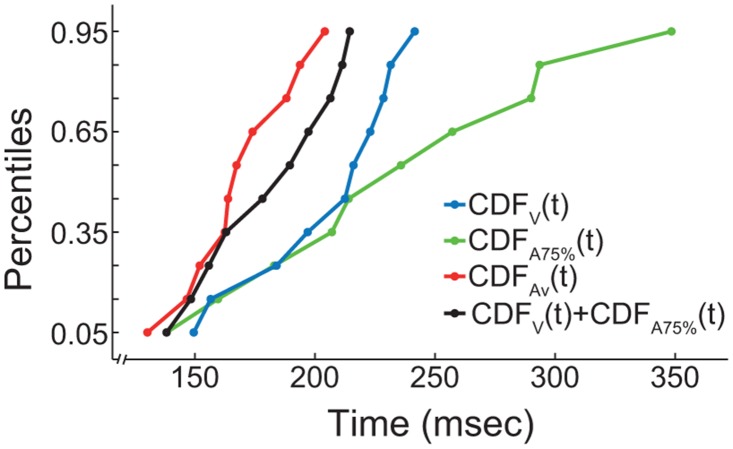
Race model example.Analysis of RT CDFs from animal 4. High visual SIC CDFs are shown for unimodal visual stimulation (V, blue), auditory stimulation at 75% (A75%, green), auditory stimulus supported by visual stimulation (Av, red) and the combination of both unimodal CDFs (V+A75%, black). In this case the race model gets rejected, because the empirical bimodal CDF (red) is ‘faster’ than the modeled CDF (black).